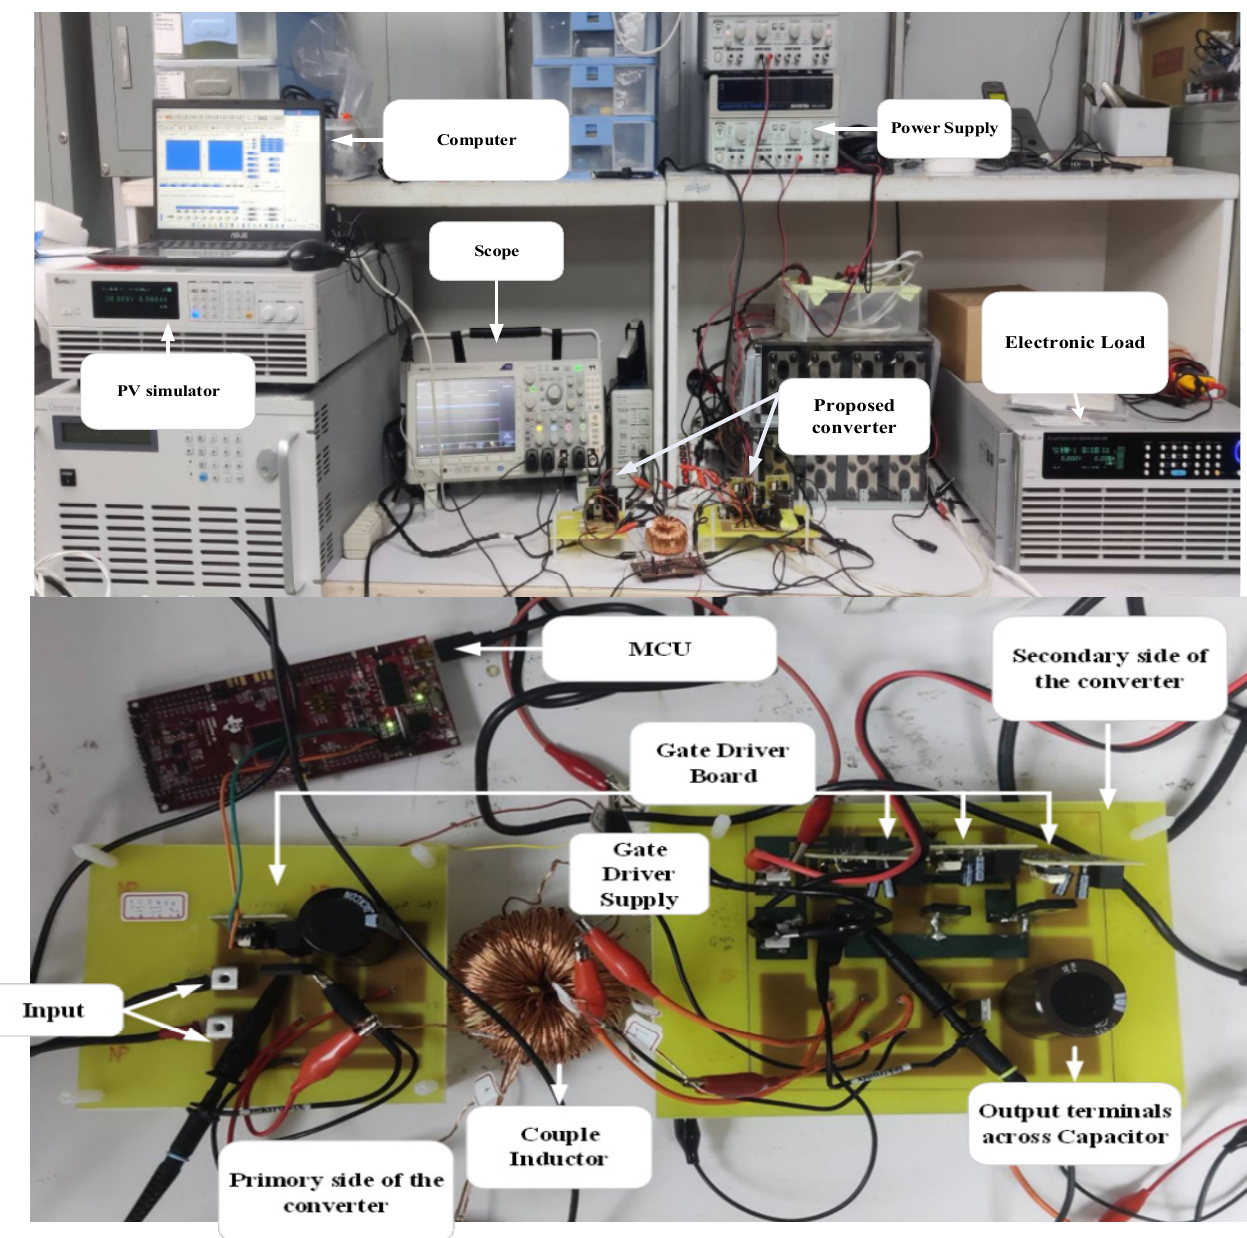
Figure 9. Hardware prototype of the proposed IIABB converter.